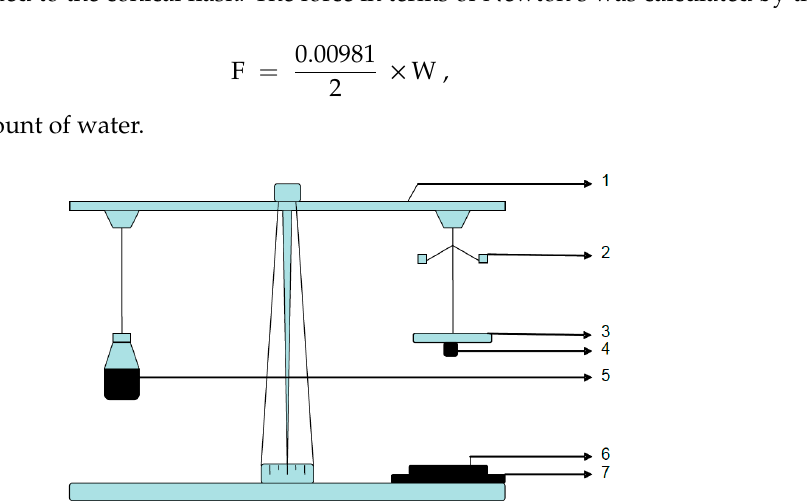
Figure 1. Experimental setup of Detachment Force Measurement. [1. Modified physical balance, 2.